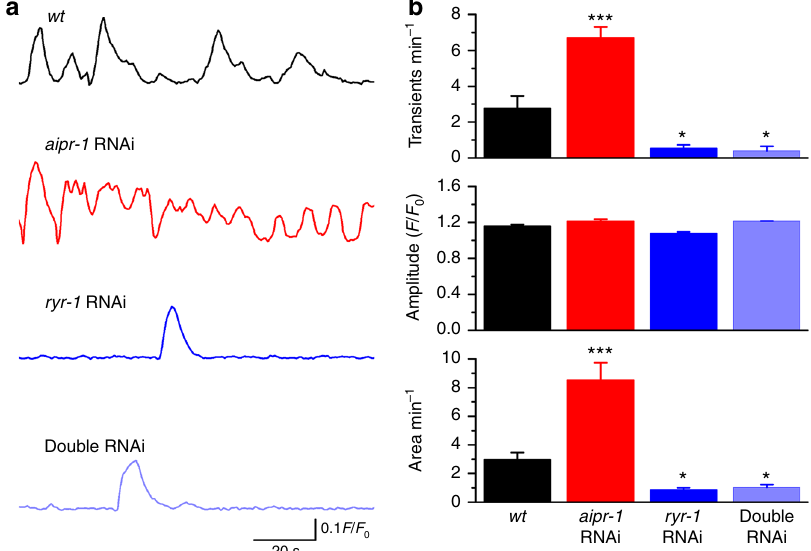
Fig. 5 AIPR-1 inhibits neuronal Ca 2+ bursts from the ryanodine receptor. Expression of either aipr-1 , ryr-1 , or both genes was knocked down in A-type motor neurons using RNAi. a Representative traces of Ca 2+ transients, determined in A-type motor neurons using GCaMP6f. b Bar graphs of calcium transient frequencies, amplitudes, and area in the wild type ( wt ) ( n = 9), aipr-1 knockdown ( n = 10), ryr-1 knockdown ( n = 6), and aipr-1 ryr-1 double knockdown ( n = 6). Data are shown as mean ± SEM. * p < 0.05, *** p < 0.001 compared with wt ; (one-way ANOVA followed by Tukey ’ s post-hoc